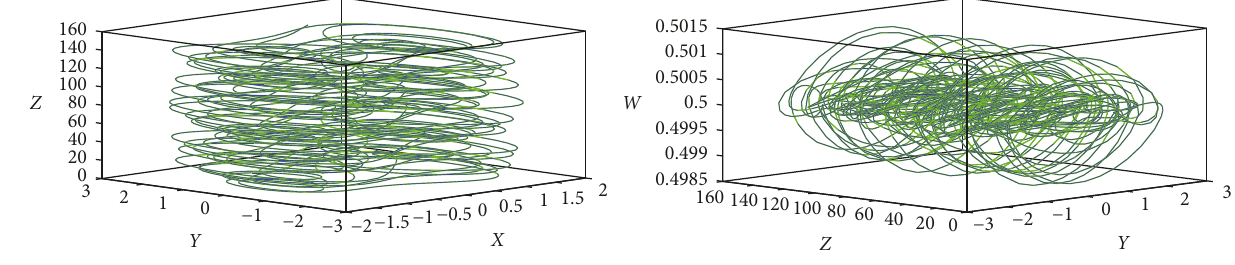
Figure 2: 3D phase portraits of the portal frame system